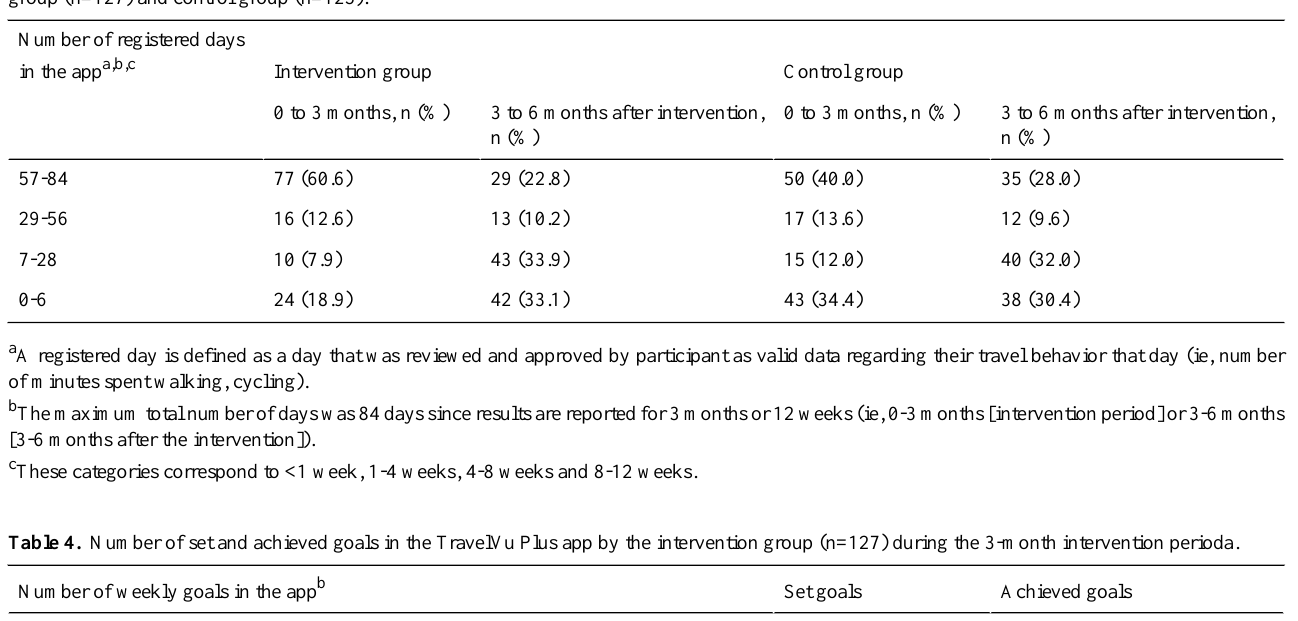
Table 3. Objective measures of engagement with the self-monitoring feature of AT in the standard version of the app (TravelVu) in the intervention group (n=127) and control group (n=125).